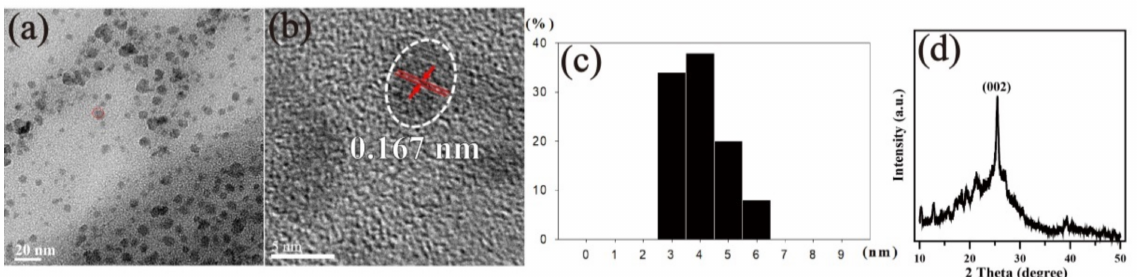
Figure 1. Analytical transmission electron microscopy (TEM) micrographs of N-doped carbon quantum dot (N-CQD) particles ( a ) at a low magnification (100 K), ( b ) with crystalline lattice of a single N-CQD (500 K). ( c ) The particle size distribution of N-CQD particles and ( d ) X-ray diffraction (XRD) pattern of N-CQD